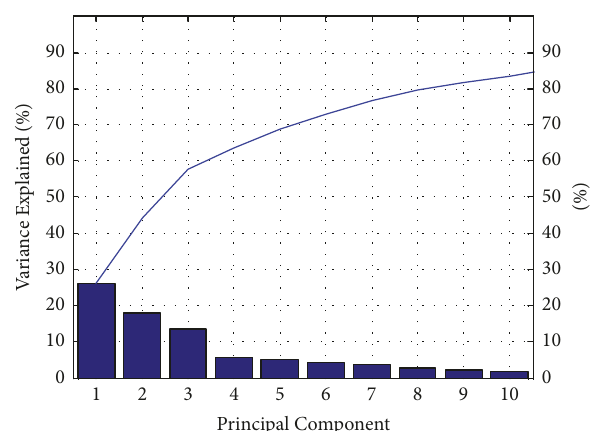
Figure 8: Accuracy with 𝐶 , 𝛾 .